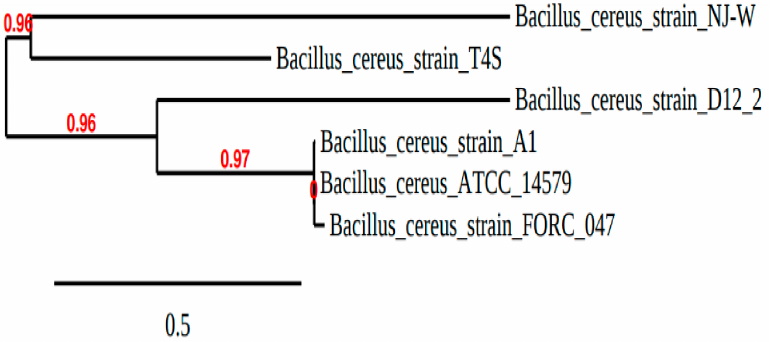
Figure 1. Phylogeny of the genome sequence data of B. cereus T4S. Legend : Scheme 0. means 96% difference between two bacterial sequences.